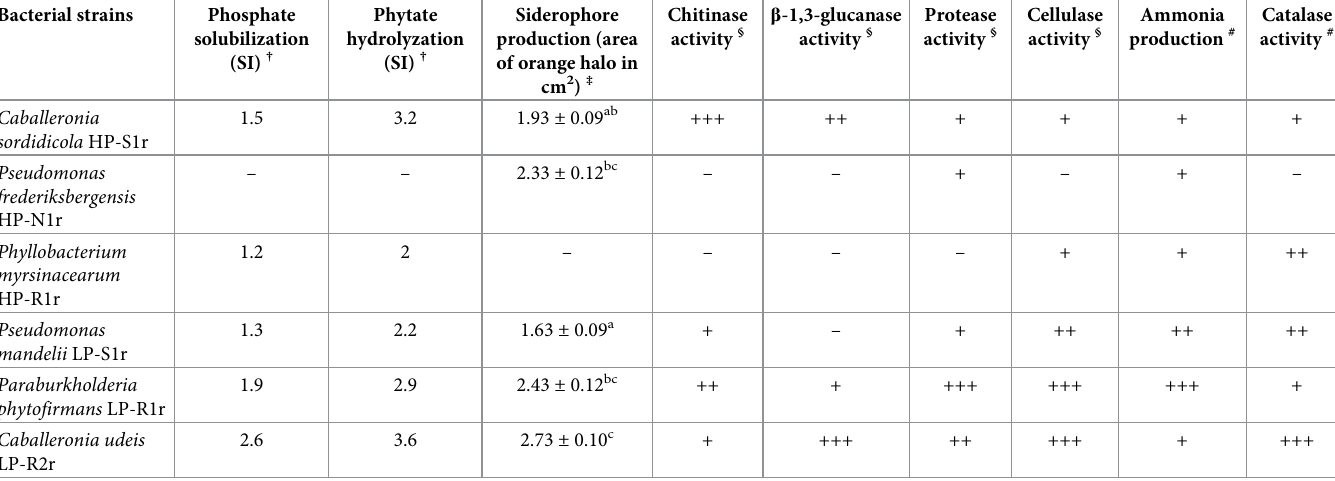
Table 1. Qualitative evaluation of major direct and indirect plant-growth-promoting mechanisms of the six bacterial strains using in vitro plate-based enzyme assays. Bacterial strains